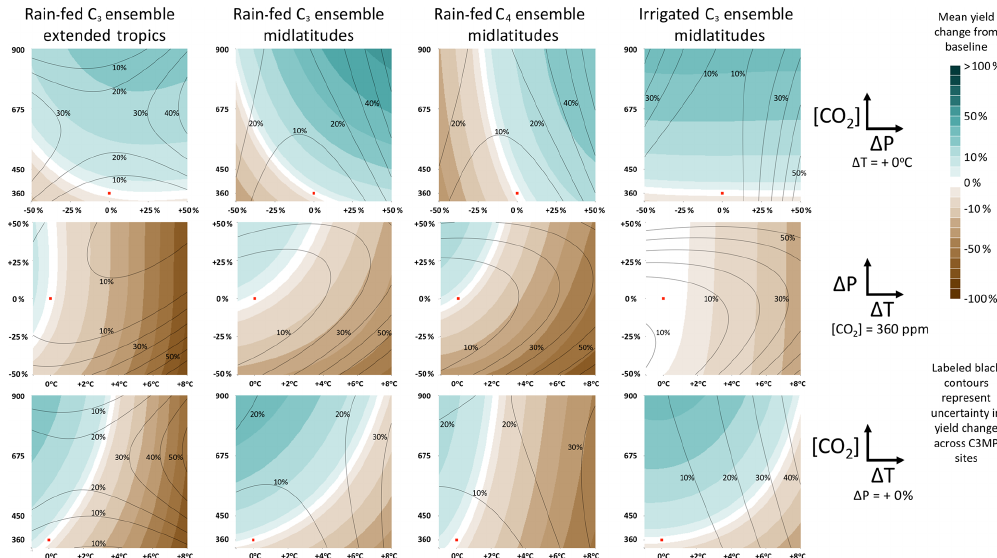
Figure 8. Select impact response surfaces – a collection of two-parameter slices of our three-parameter space (not a visualization of the full space). The color represents the yield change for a given local CTW perturbation as a percentage of baseline yields (1980–2009 planting year average; positions shown as red squares). Labeled black contours are uncertainty across the submitted site-specific crop models.